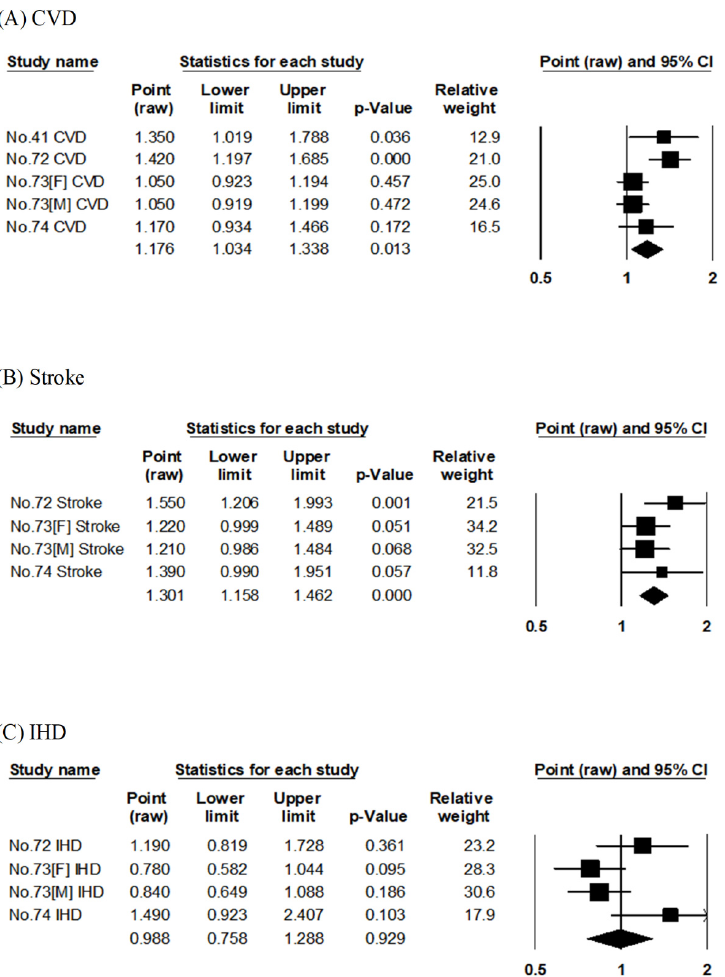
Figure 7. Meta-analysis of salt consumption and mortality risk. ( A – C ) show the association between salt consumption and CVD, stroke, and IHD mortality risk, respectively. The area of each square is proportional to the study weight. Horizontal lines represent 95% confidence intervals. Diamonds represent pooled estimates from inverse-variance-weighted random-effects model. The number given in the study name indicates that of the cited reference [41,72–74]. CVD; cardiovascular disease, IHD; ischemic heart disease.